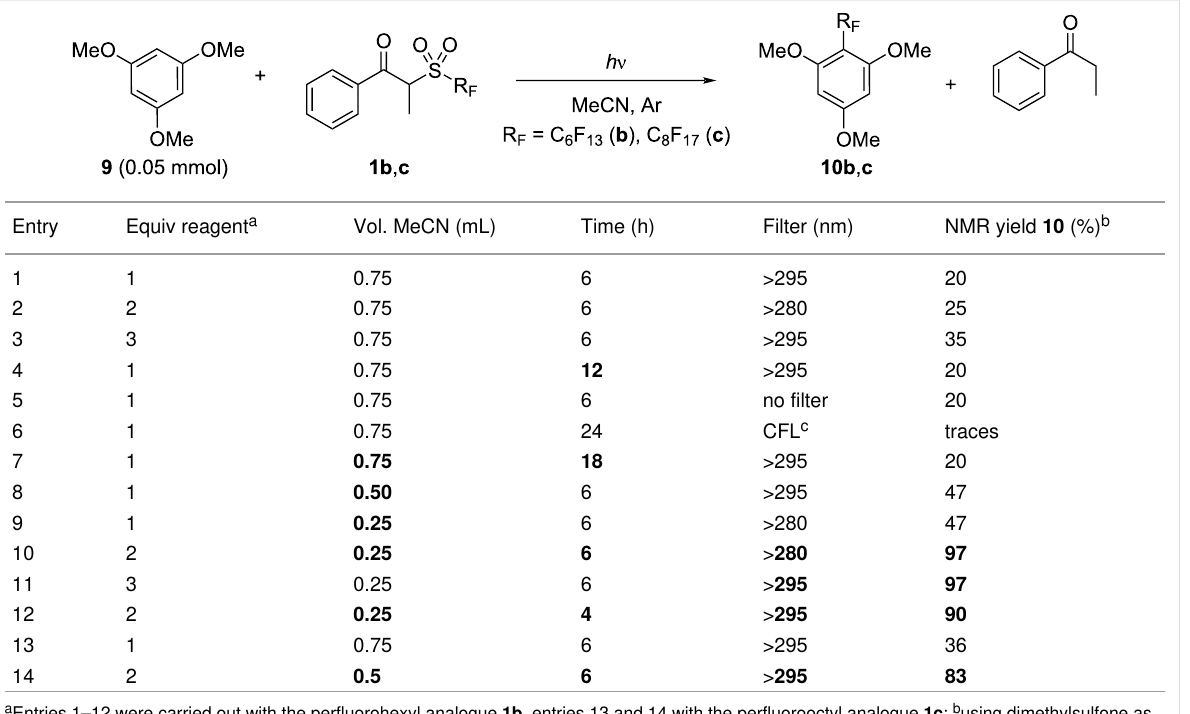
Table 2: Optimization for the perfluoroalkylation of aromatics under UV light.